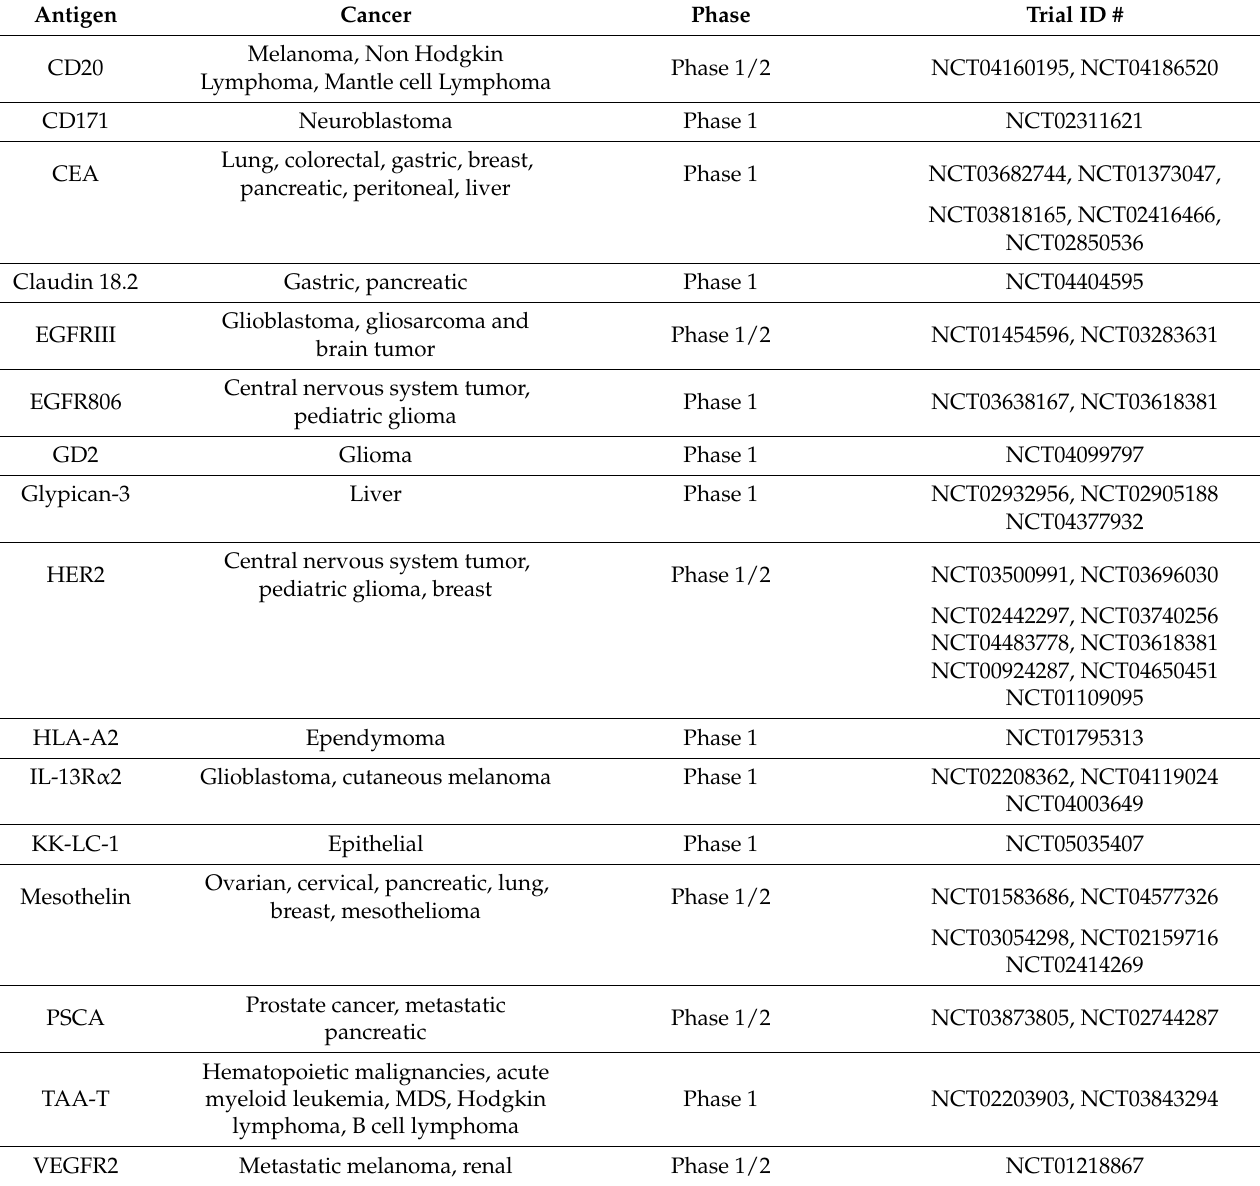
Table 1. Commonly targeted solid tumor antigens in clinical trials in